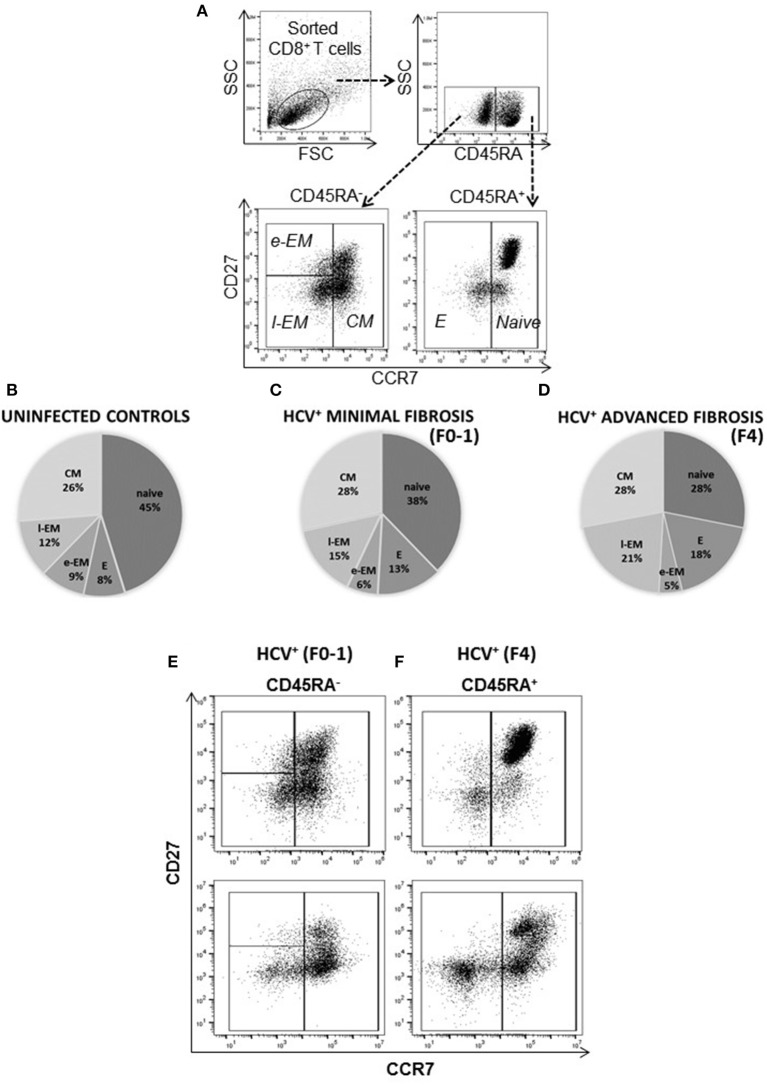
The degree of liver fibrosis in chronic HCV infection is associated with altered circulating CD8+ T-cell subset distribution. CD8+ T-cells were isolated from PBMCs for analysis of subset distribution. The proportions of cell CD8+ T-cell subsets were distinguished based on surface marker expression by flow cytometry as follows: Naïve (CD45RA+CCR7+CD27+/−), Effector (E, CD45RA−CCR7−CD27−), Early Effector Memory (e-EM, CD45RA−CCR7−CD27+), Late Effector Memory (l-EM, CD45RA+/−CCR7−CD27−), and Central Memory (CM, CD45RA−CCR7+CD27+/−). (A) Representative dot plots of the lymphocyte gate (forward vs. side scatter) and phenotype strategy are shown. The distribution of (B) uninfected controls (n = 9) and treatment naïve HCV+ individuals with (C) minimal (Metavir score F0-1, liver thickness ≤7.0 kPa, n = 9) or (D) advanced liver fibrosis/cirrhosis (F4, ≥12.5 kPa, n = 5) are shown with pie-charts [mean percentages (%), subset S.D. < ±10%]. Representative dot plots of CD8+ T-cell subset distribution in the (E) HCV+ (F0-1) and (F) HCV+ (F4) study groups are shown.